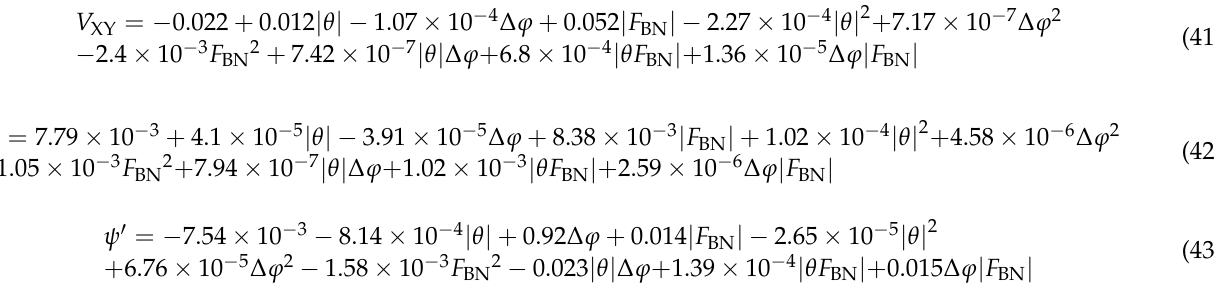
Figure 10. Accuracy of approximate models ( Z ´ ( a ), V XY ( b ) and ψ ´ ( c )